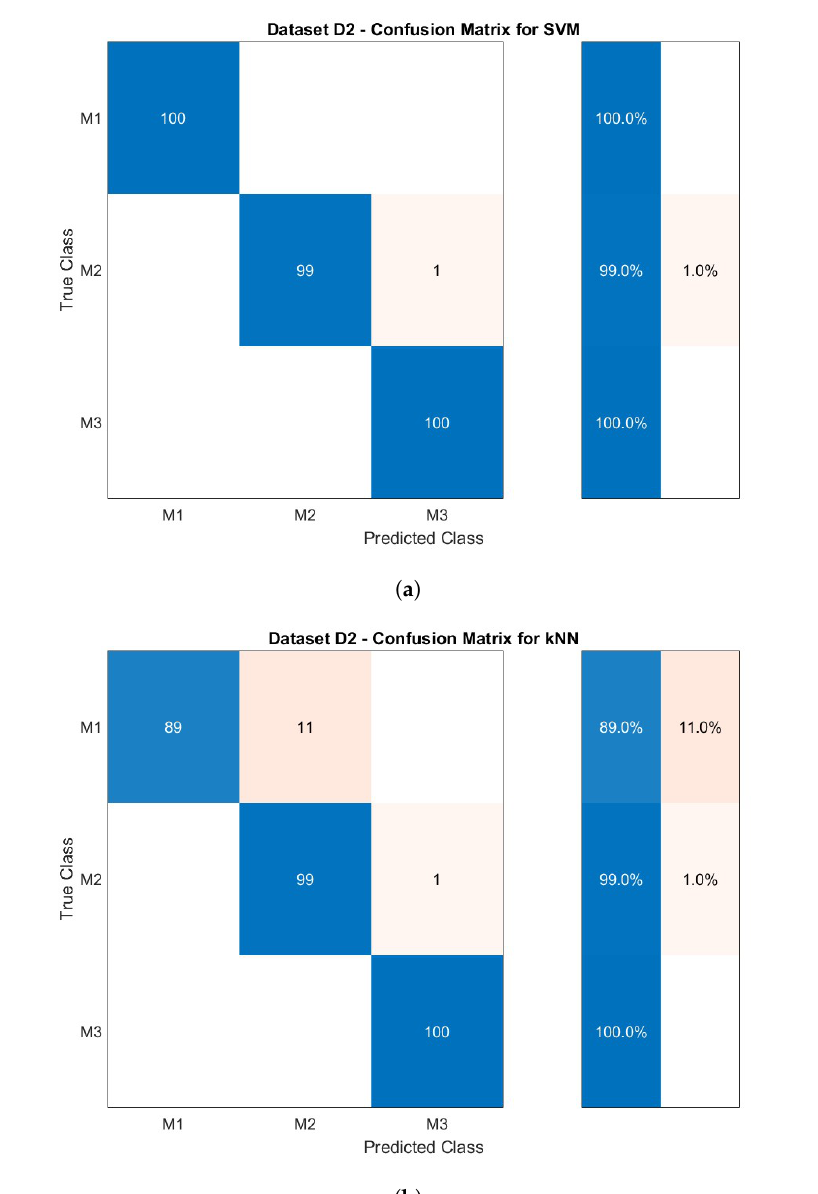
Figure 6. Confusion matrix for dataset D2 for classifier SVM ( a ) and classifier kNN ( b ) along with the sensitivity on the right side